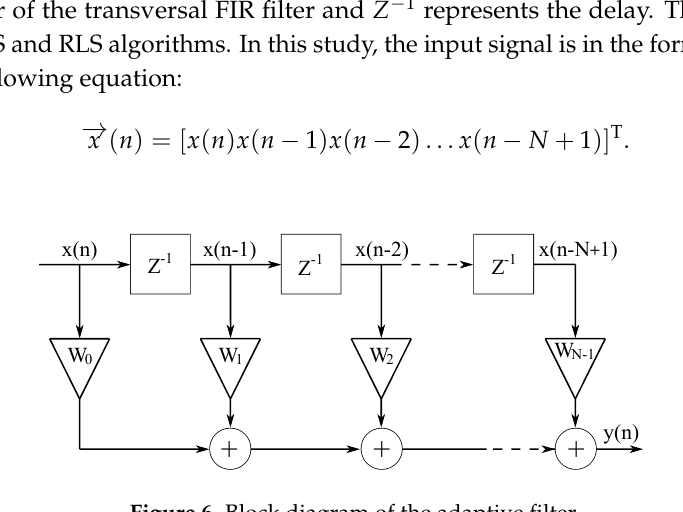
Figure 6. Block diagram of the adaptive